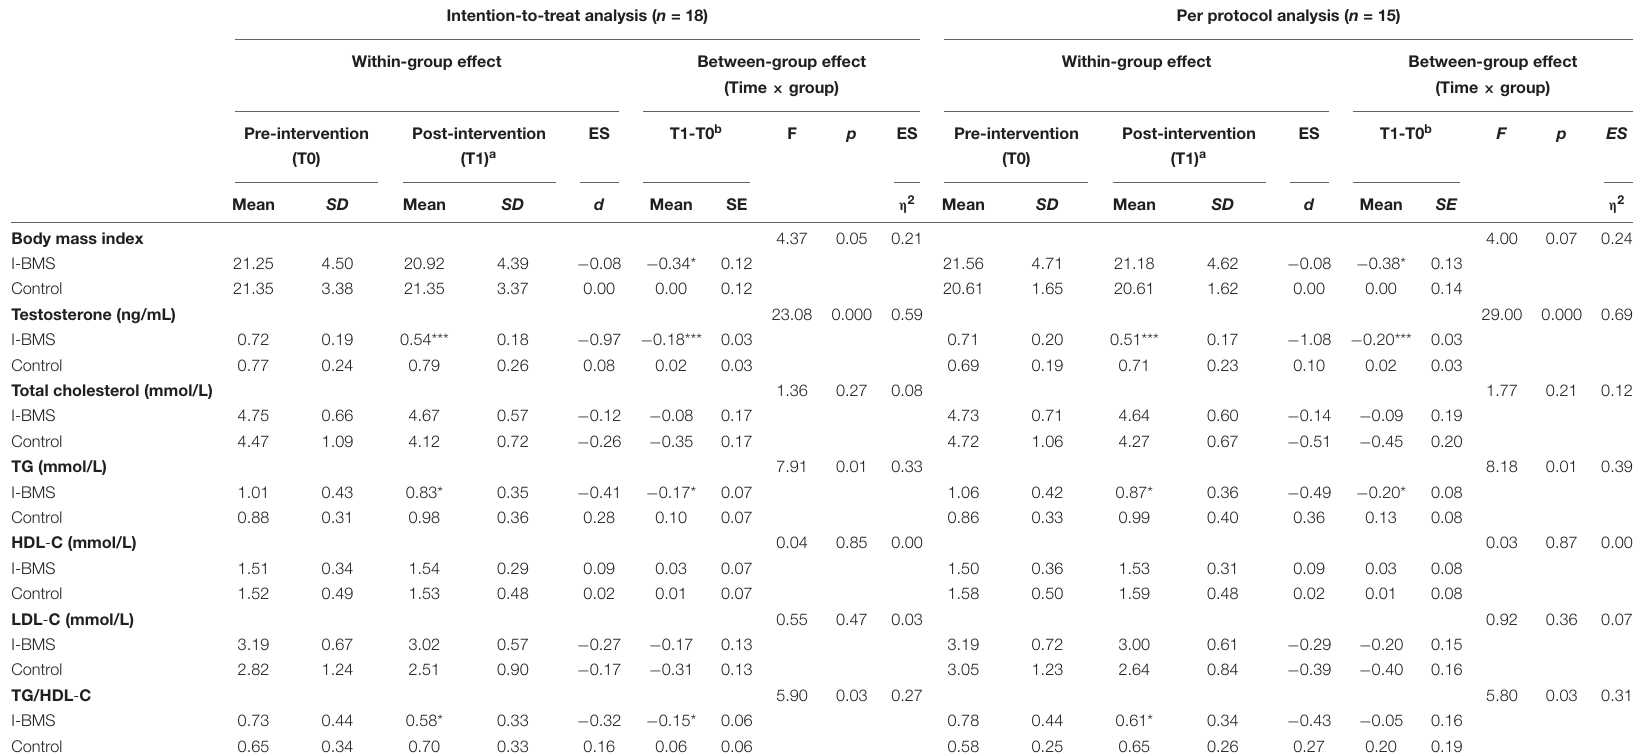
TABLE 4 | Pre- and post-intervention tests of physical